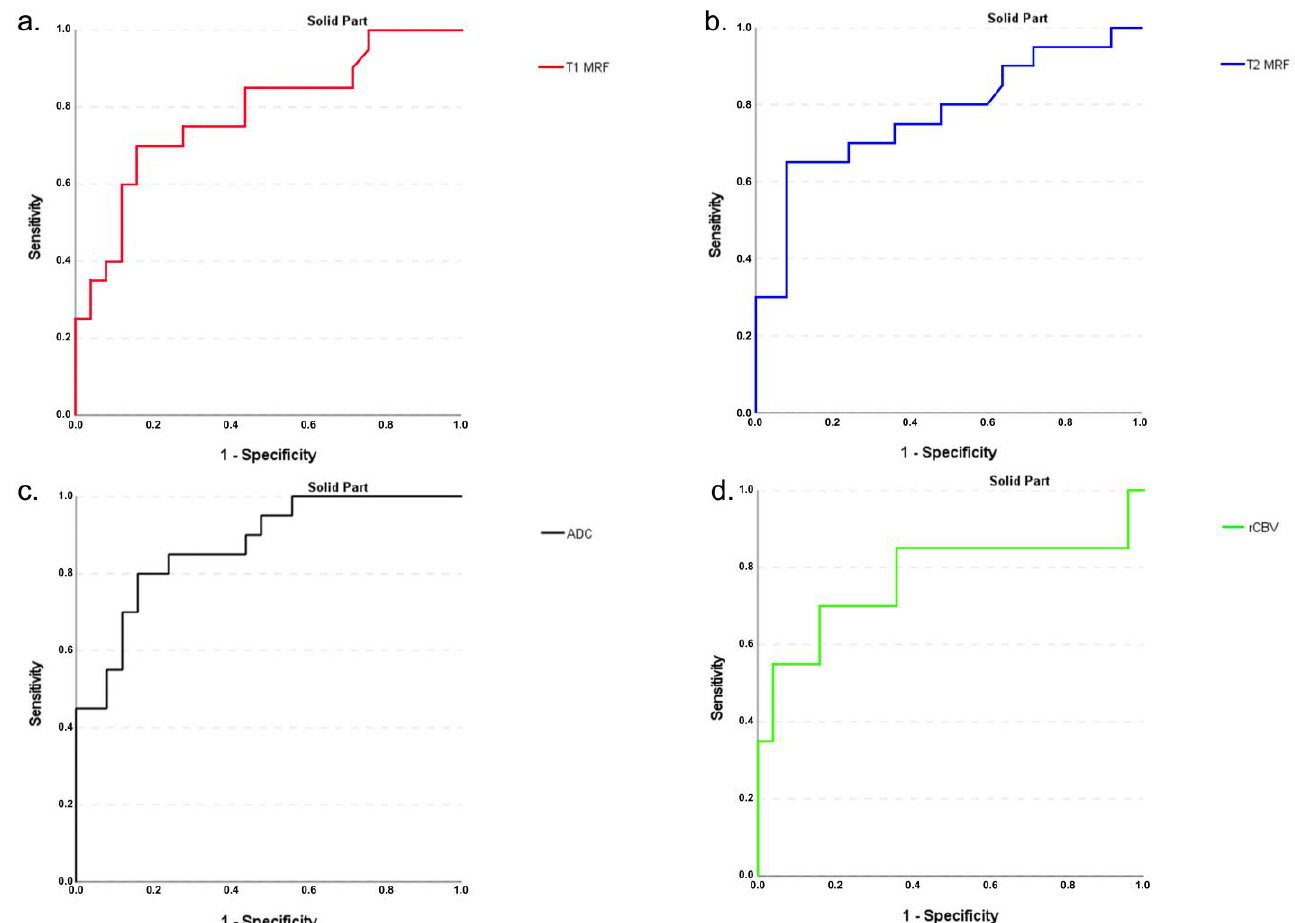
Figure 4. Receiver operating characteristic (ROC) curves to differentiate the solid parts of the IDH mutant (without 1p/19q codeletion) from the IDH-wildtype for the mean of MRF T1 ( a ) and T2 relaxation time values ( b ), ADC values ( c ), and rCBV values ( d ). The area under the curve AUC for MRF T1 (0.791) ( a ) and T2 (0.754) ( b ) shows that differentiation can well be performed, as with ADC (0.875) and rCBV (0.239).